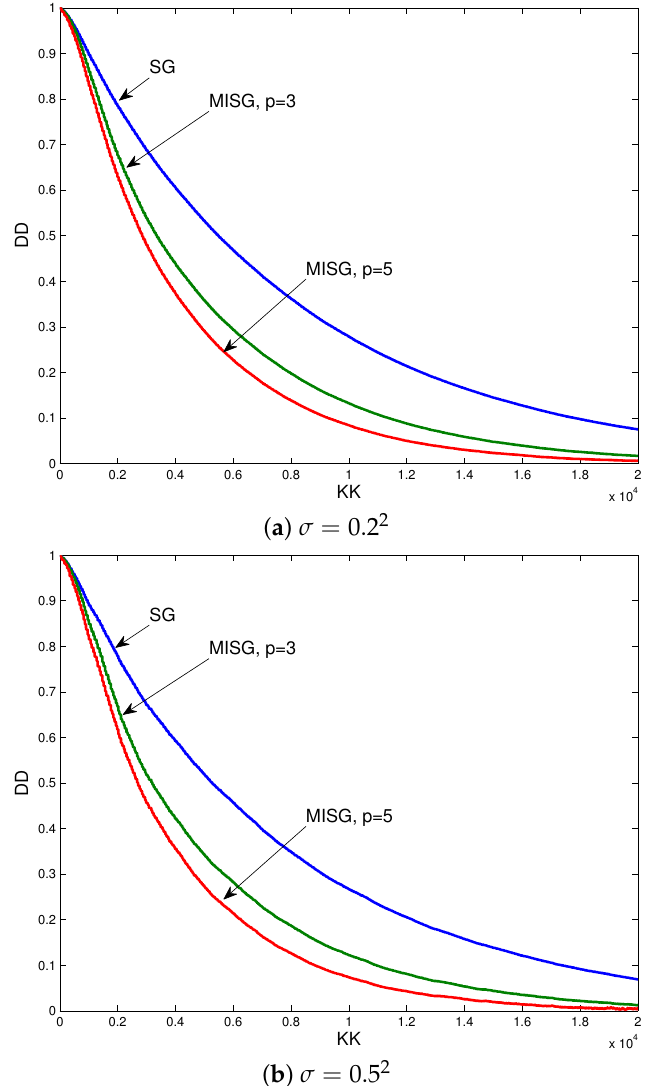
Figure 3. Parameter estimation errors δ versus k using SG and